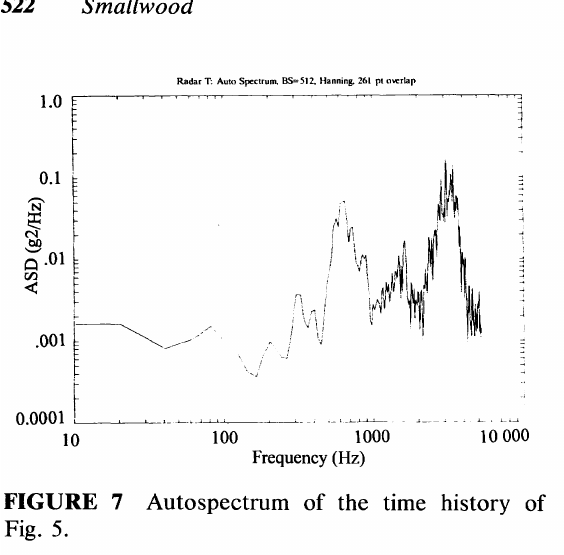
FIGURE 7 Autospectrum of the time history of Fig. 5.